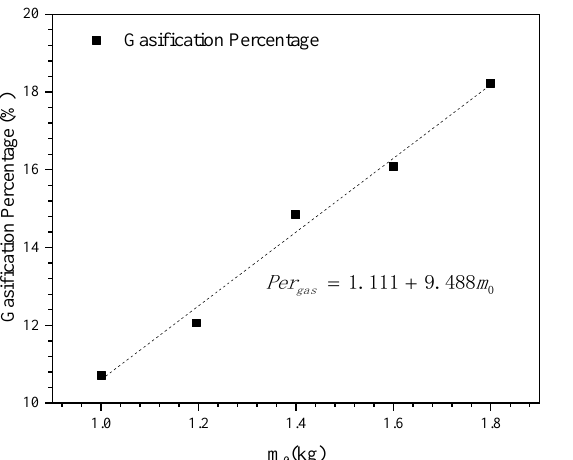
Figure 17. Variation of gasification ratio of extinguishing agent under different filling